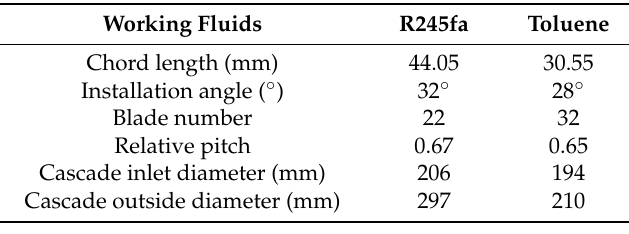
Table 3. Geometric parameters of stator blades.